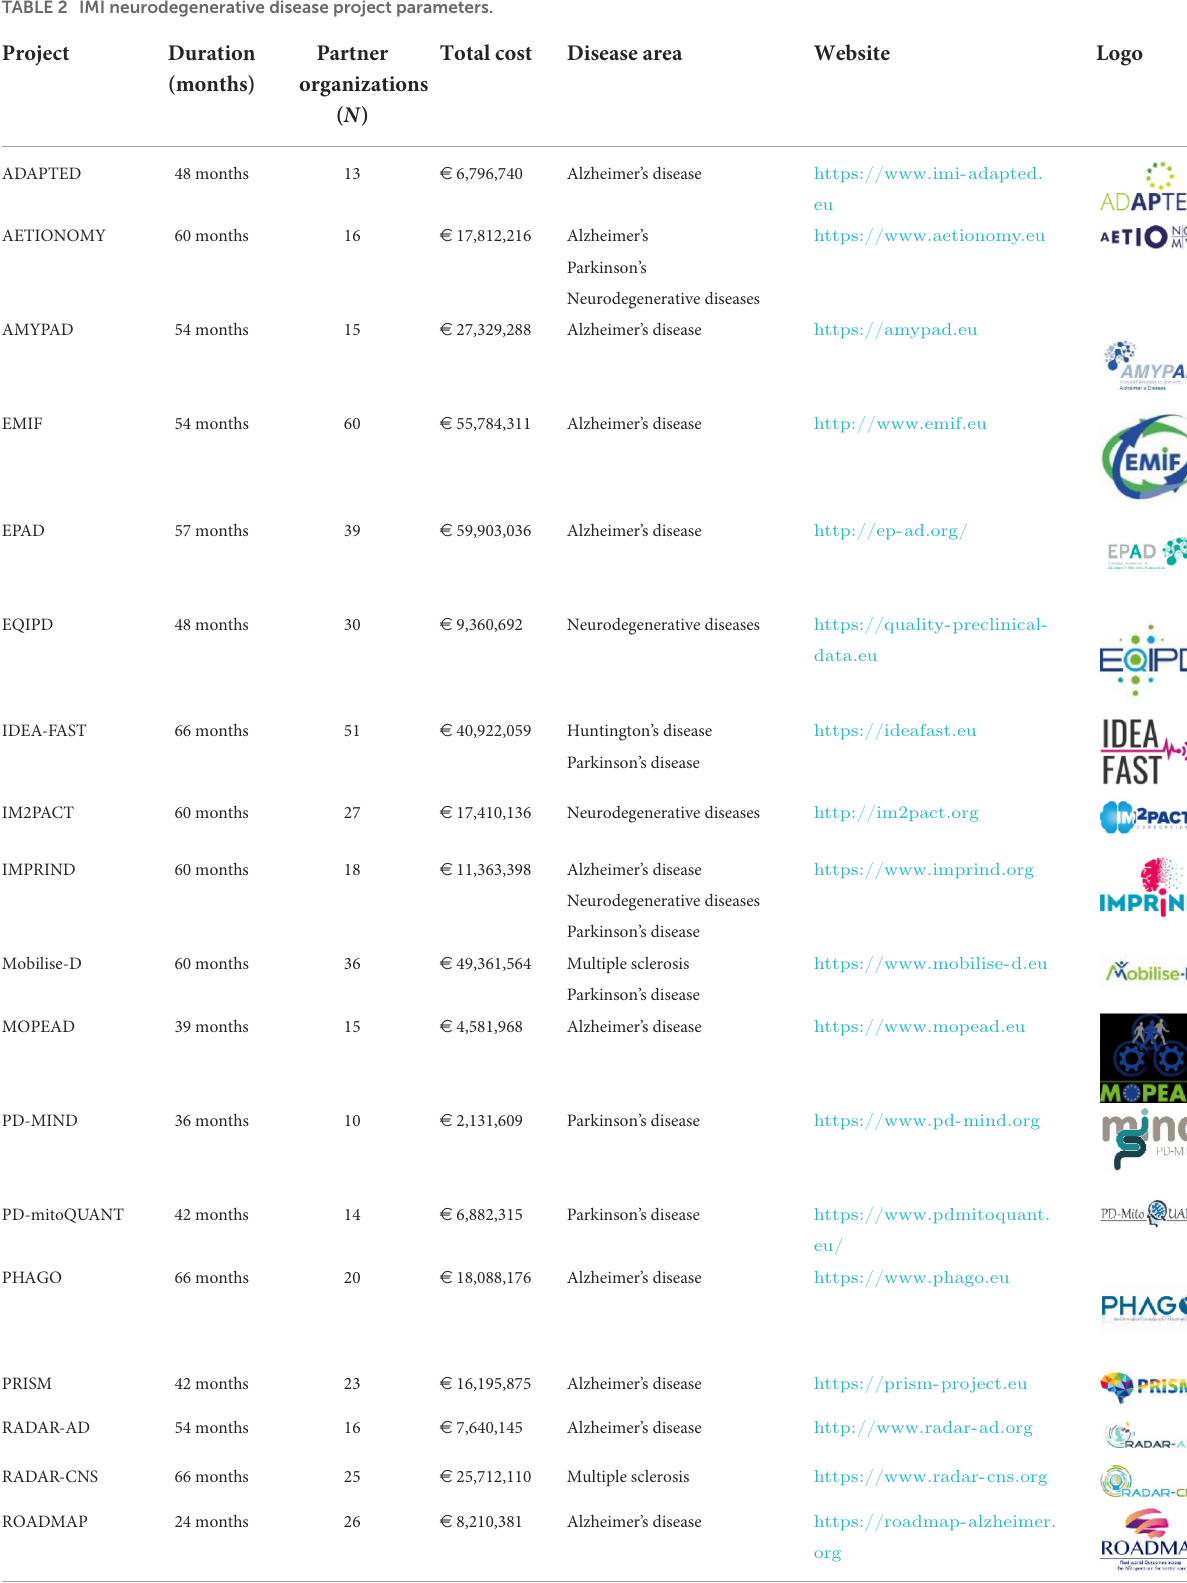
TABLE 2 IMI neurodegenerative disease project